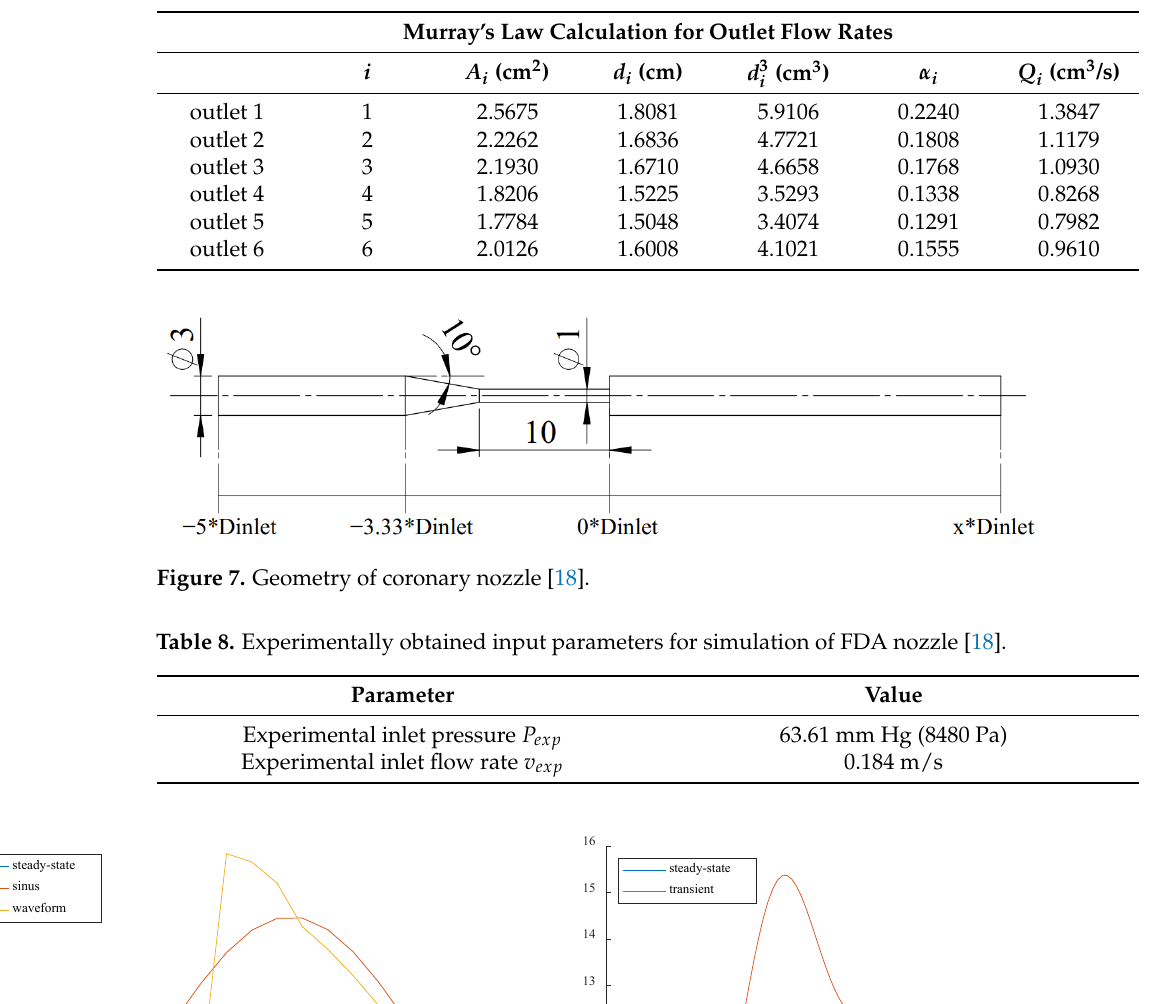
Table 7. Initial calculated flow rates at each outlet by Murray’s law for CHN03 [19].